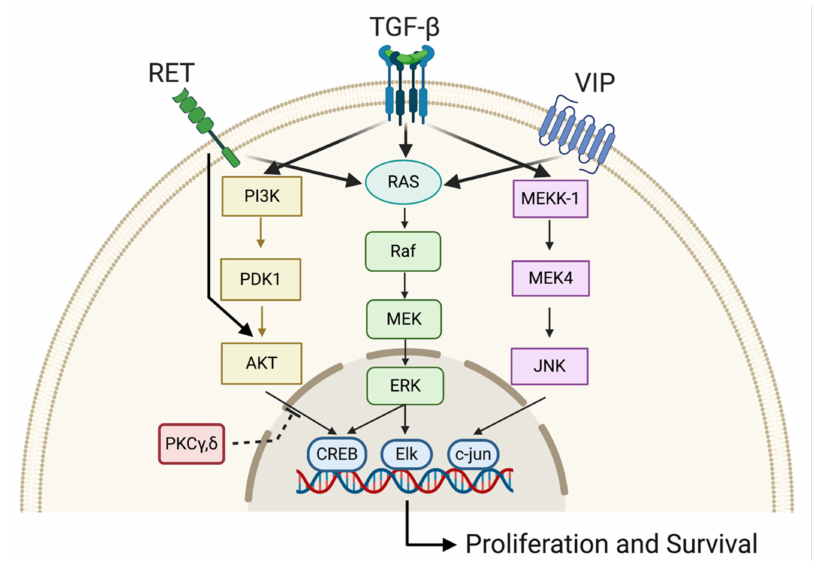
Figure 3. Schematic of the pathways interacting with the RA signalling cascade. Created with BioRender.com (accessed on 9 February